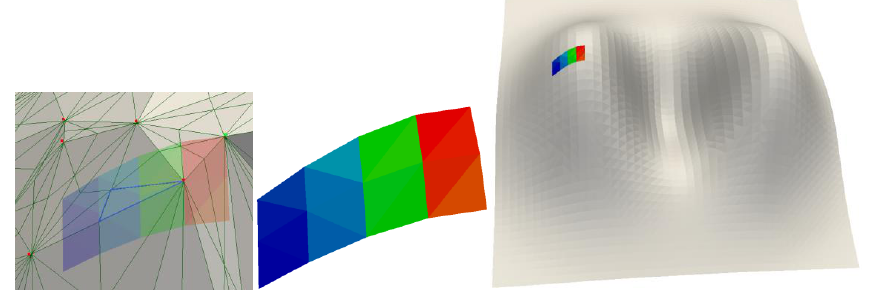
Figure 4. A triangle T j (rendered in semi-transparent blue) with its minimal bounding box’s intersection part narrPd with the original grid on the approximate grid (left), the localised intersection part narrPd (middle), and the intersection part on the original grid oriPd (right).